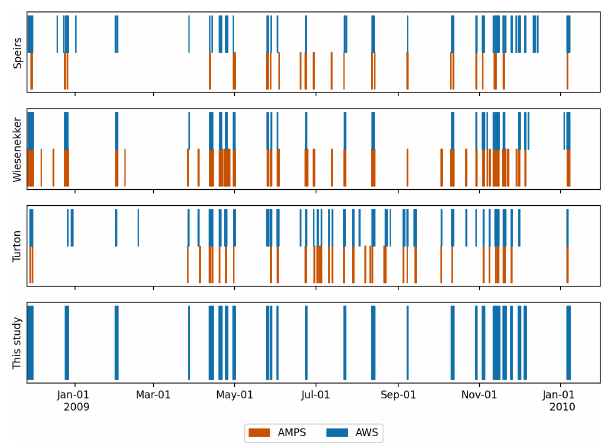
Figure B1. Foehn detected by the Speirs, Wiesenekker and Turton methods using temperature, relative humidity and wind speed from AWS observations (blue) or AMPS forecast (red) at Joyce Glacier.